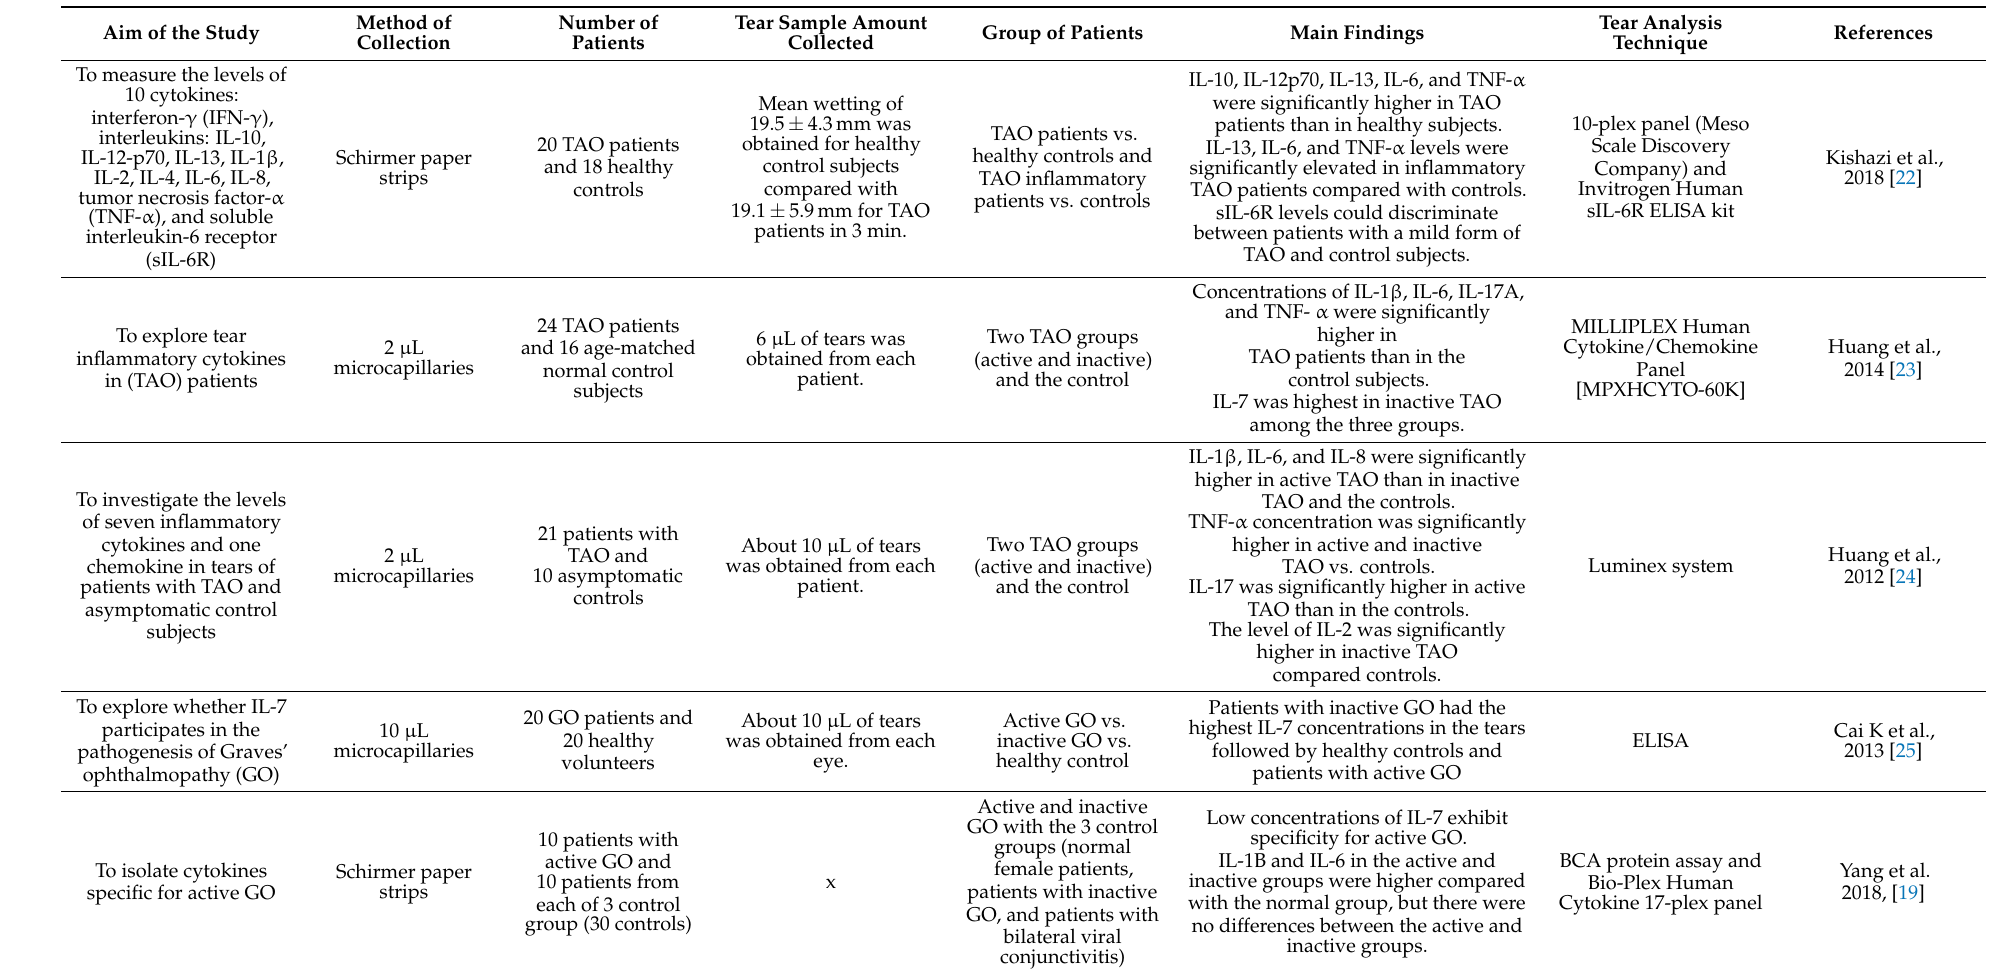
Table 1. Summary of studies examining cytokines in tears of GO